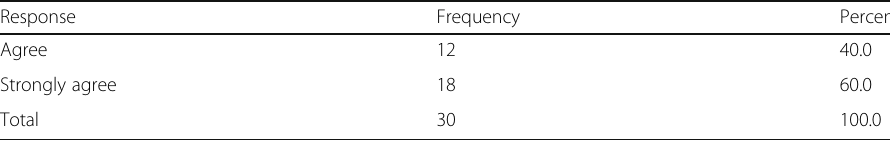
Table 2 The Boankra inland port has increased skills of staff Response Frequency Percent Agree 12 40.0 Strongly agree 18 60.0 Total 30